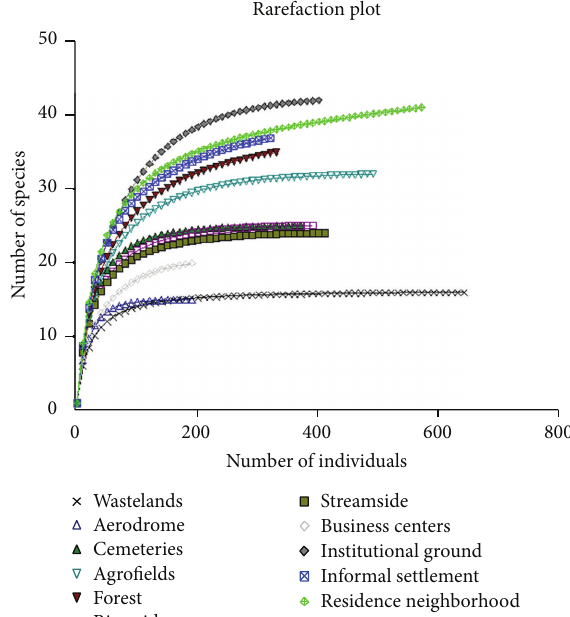
Figure 1: Bird species rarefaction curves at the site considered in this study.